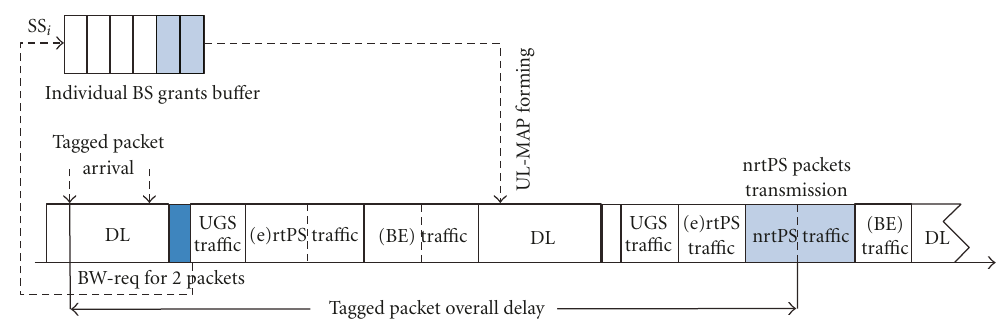
Figure 7: Example BS uplink scheduling for a single